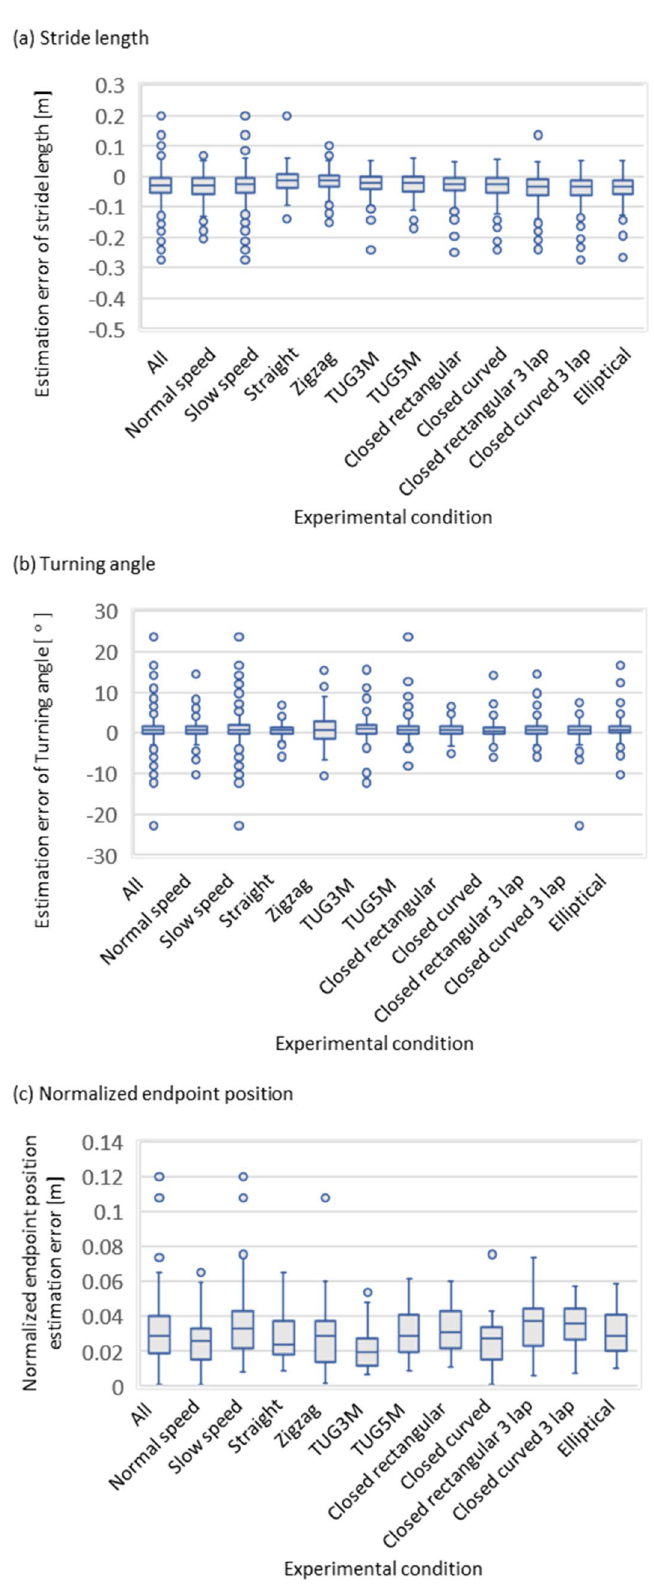
Figure 5. Box plot results of evaluating the estimation error of the proposed method compared to the golden standard in the stride length the turning angle, and the normalized endpoint position, respectively. These results are evaluated under two walking speed conditions and the nine walking route